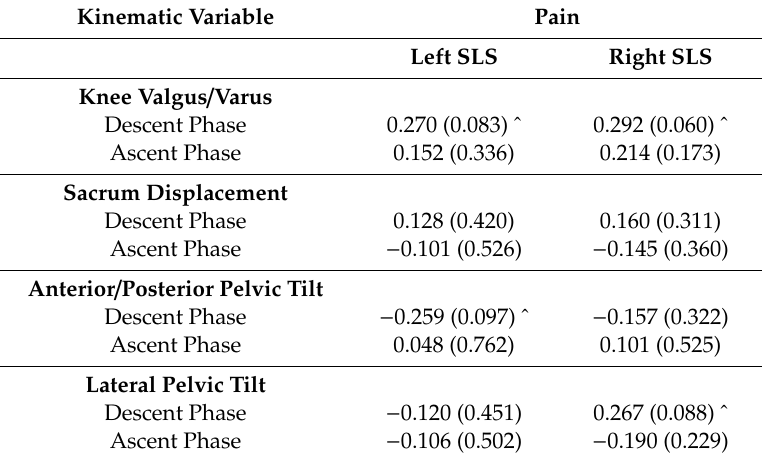
Table 3. Pearson Point Biserial Correlations between Pain and Z -scores of Kinematic Data across Each